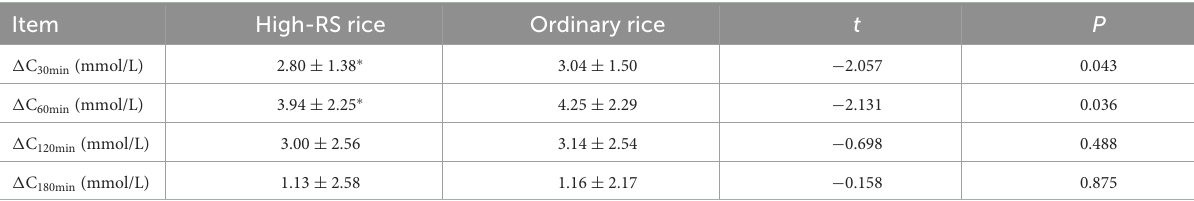
TABLE 3 Comparisons of postprandial blood glucose levels (mean ± SD) between high-RS rice meal and ordinary rice meal ( n = 73). Item